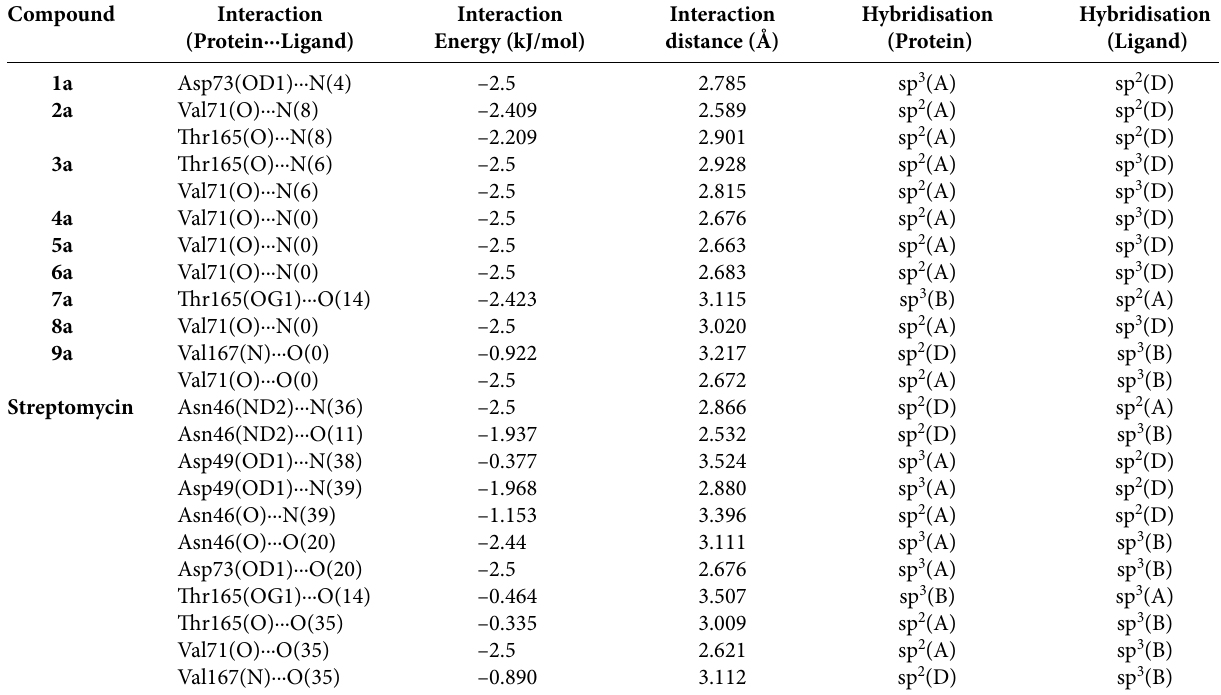
Table 6. Molecular interaction analysis of the compounds with the active site of 1KZN Compound Interaction Interaction Interaction Hybridisation